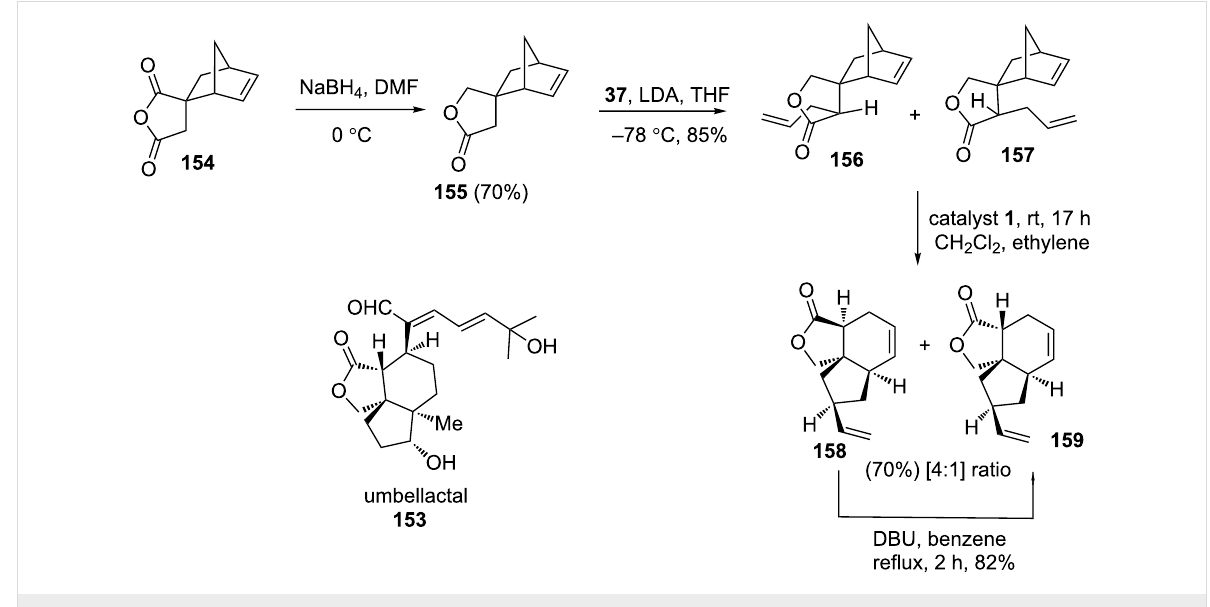
Scheme 32: RRM protocol to functionalized tricyclic